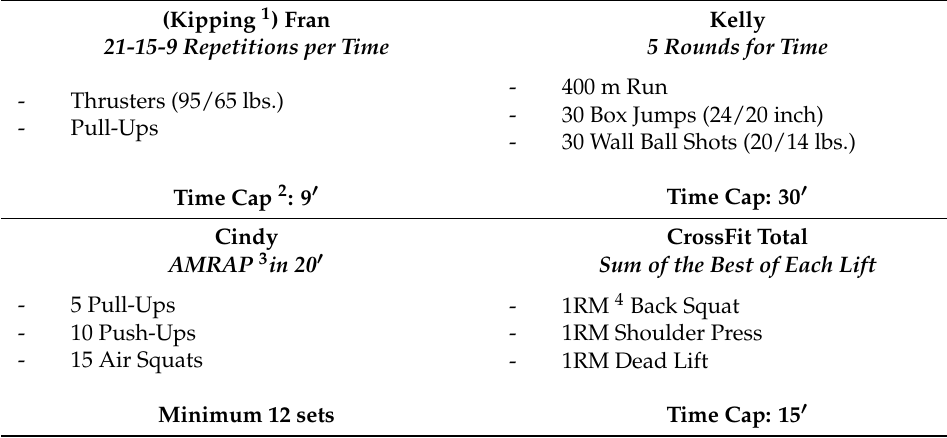
Table 1. WODs requirement for sample